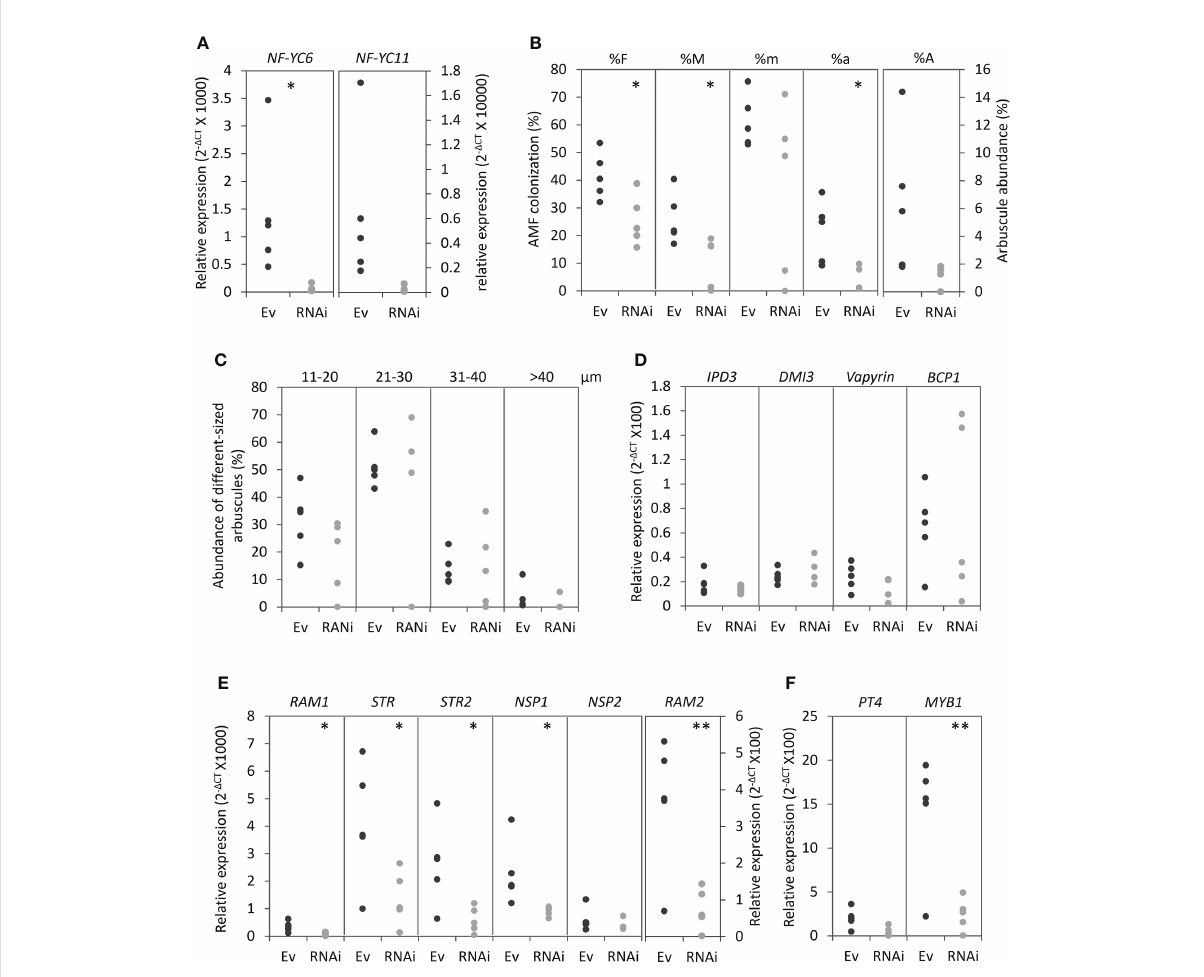
FIGURE 4 The phenotypic analysis of MtNF-YC6 and MtNF-YC11 RNAi roots. (A) The relative expression level of MtNF-YC6 and C11 in empty vector control (Ev) and RNAi roots (RNAi). (B, C) Parameters of AMF colonization (B) and the size distribution of arbuscules (C) in Ev and RNAi roots. (D-F) The relative expression level of AMS marker genes which participated in symbiotic signaling pathway, arbuscule development and arbuscule degeneration. The dark and light gray dots mean Ev and RNAi samples, respectively. n = 5. Student ’ s t test evaluated the difference between Ev and RNAi. *p<0.05,